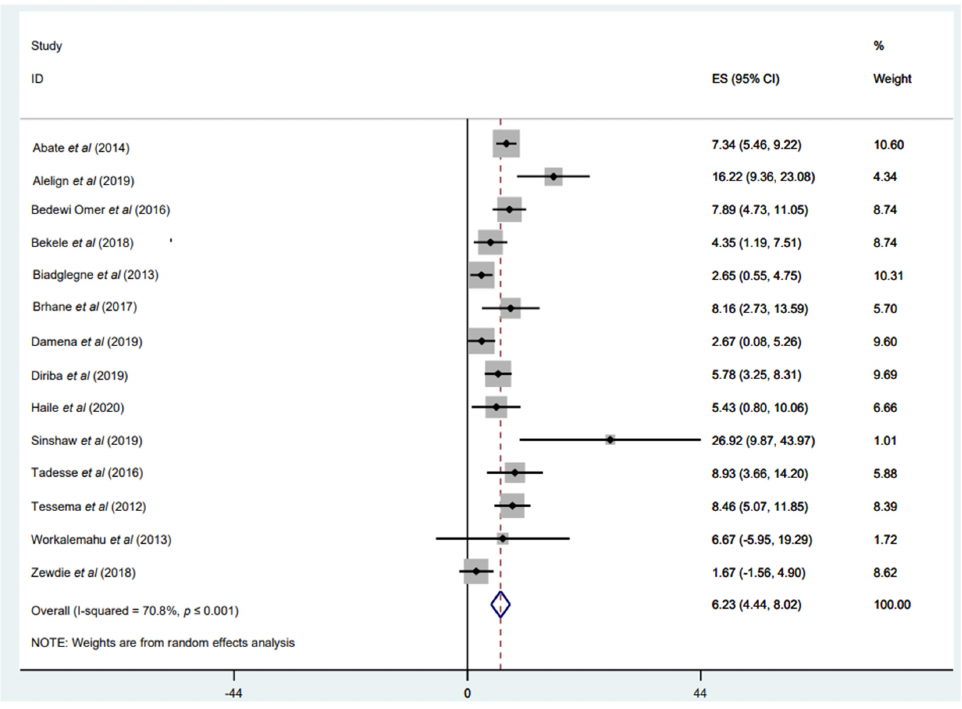
Figure 5. Forest plot showing the weighted pooled prevalence of isoniazid (INH)-monoresistance in tuberculosis (TB) patients.